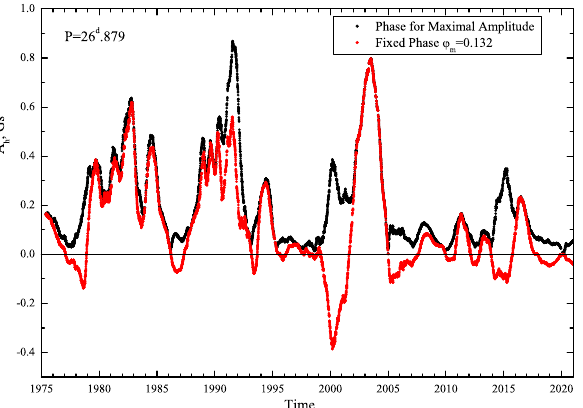
Figure 5. Time variation of the harmonic amplitude of oscillations for the period P = 26 d .879: black dots are the amplitude with a phase that gives the maximum value of A h ; red dots are the ampli- tudes for fixed phase φ m = 0.132.